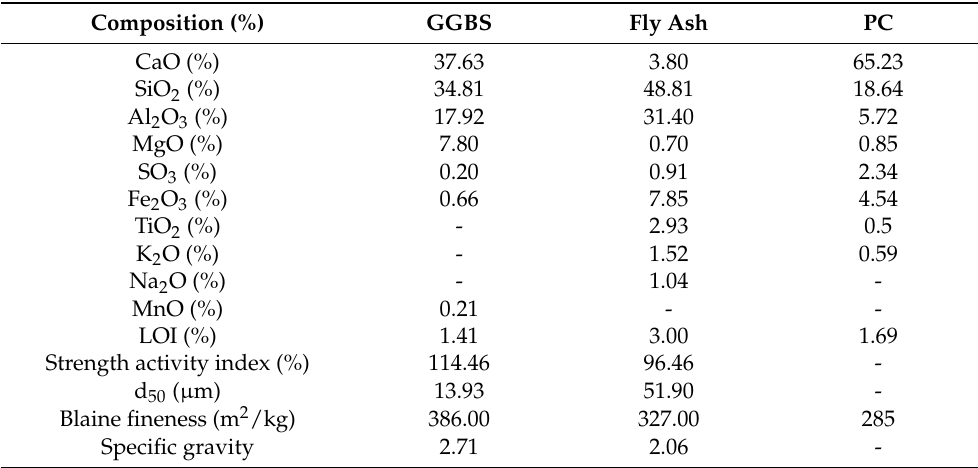
Table 1. Chemical composition of binders